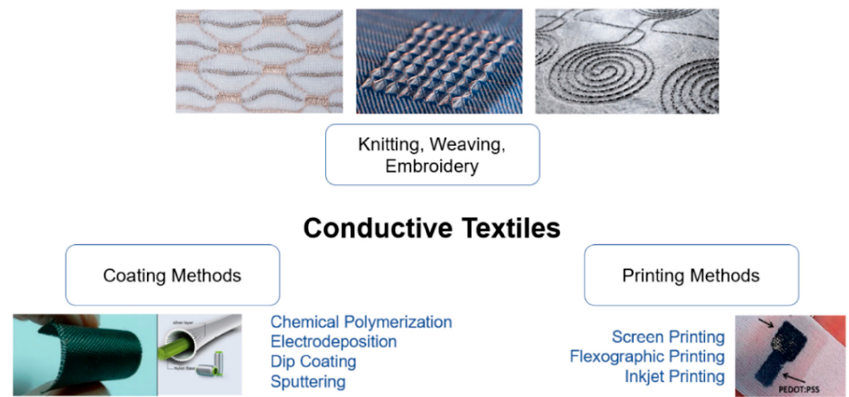
Figure 1. Most common manufacturing techniques of conductive textiles: knitting, weaving, embroidery; coating methods; printing methods. Table 1. Synthesis of the main advantages and disadvantages of the manufacturing techniques.